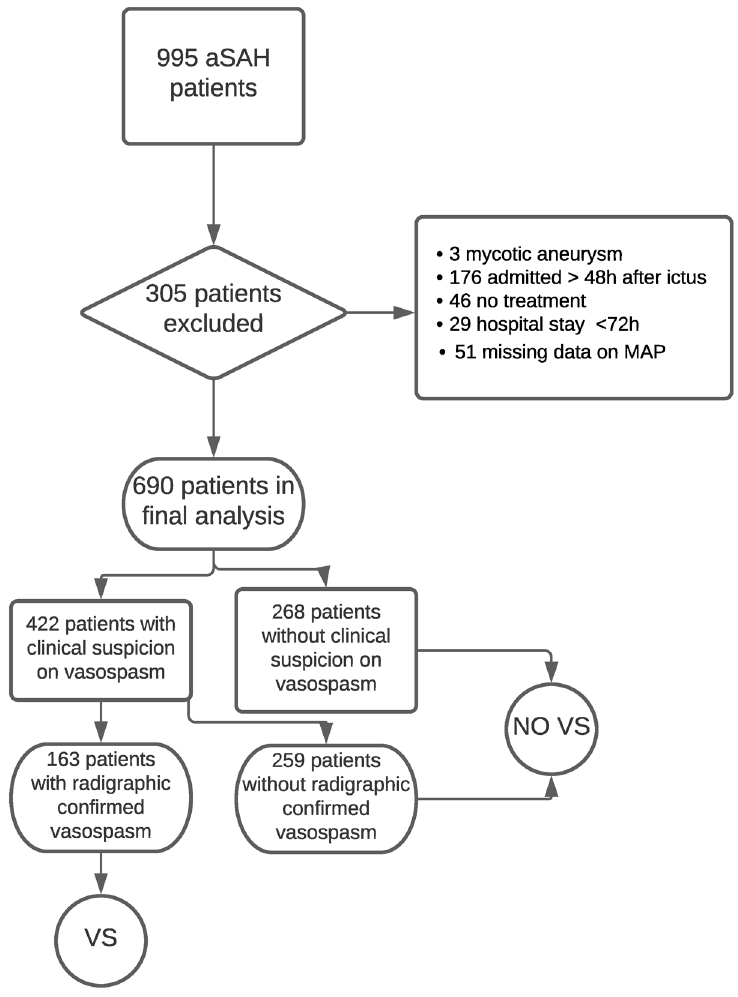
Figure 1. Overview of the recruitment process of the study. aSAH aneurysmal subarachnoid hemorrhage, MAP mean arterial pressure, (NO) VS (no)